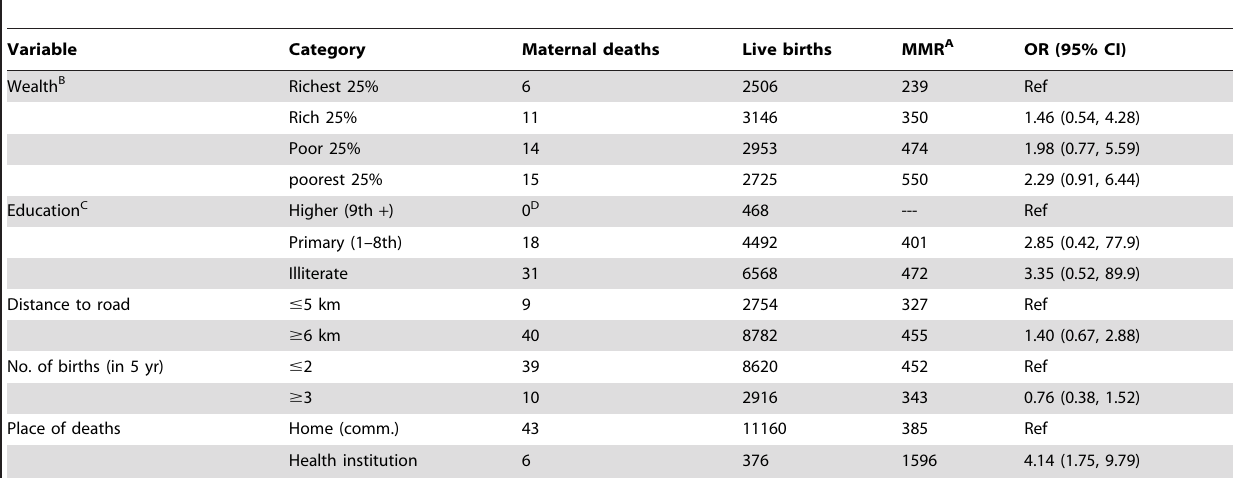
Table 4. Maternal mortality across socio-economic factors, south-west Ethiopia, 2006–2010.